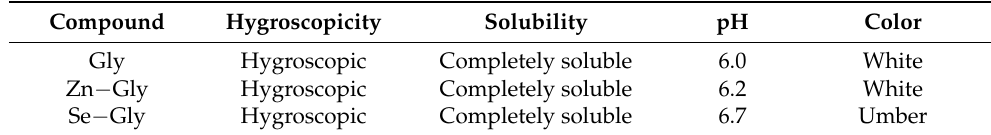
Table 3. Characteristics of Gly − chelated Zn and